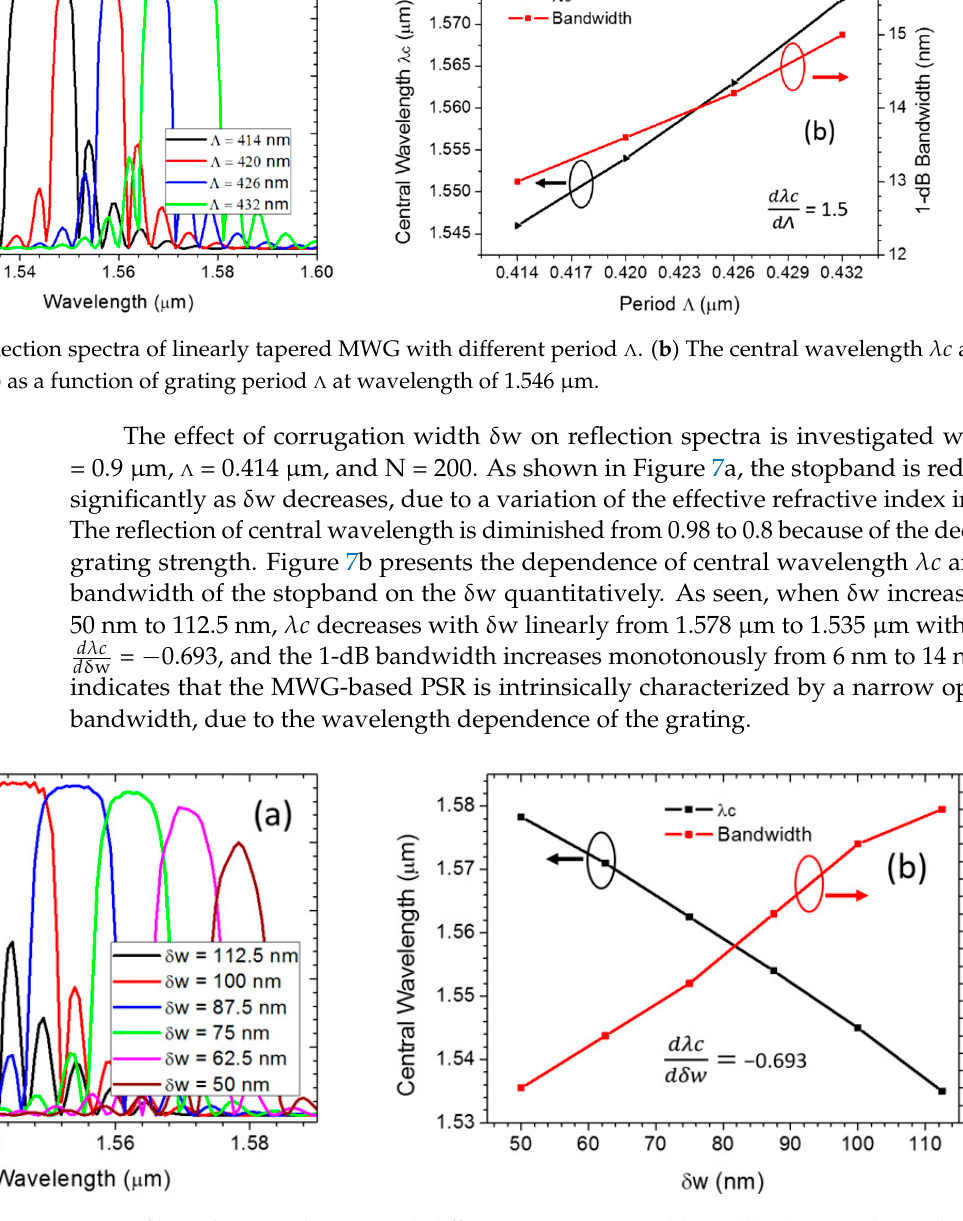
Figure 7. ( a ) The reflection spectra of linearly tapered MWG with different corrugation width δ w. ( b ) The central wavelength and 1 dB bandwidth as a function of δ w.